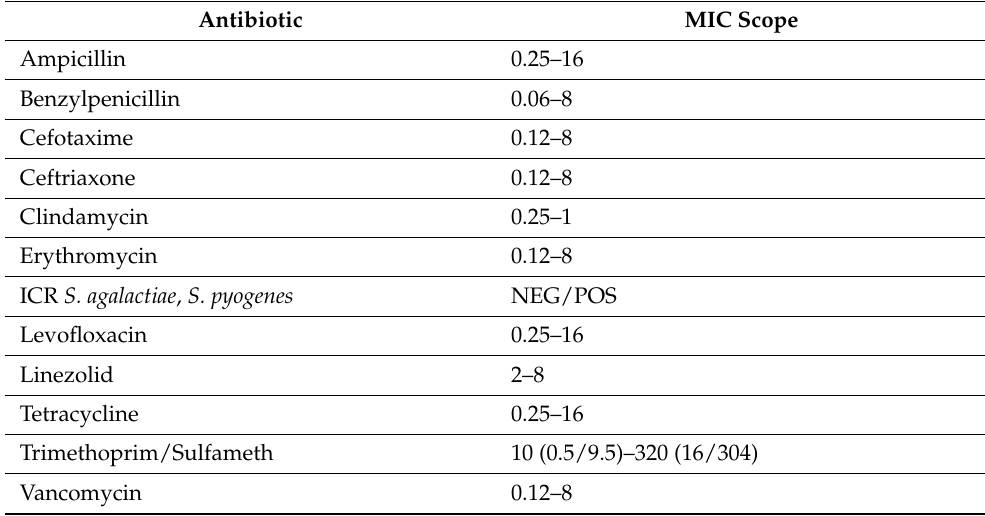
Table 1. Antibiotic panel of AST-ST01